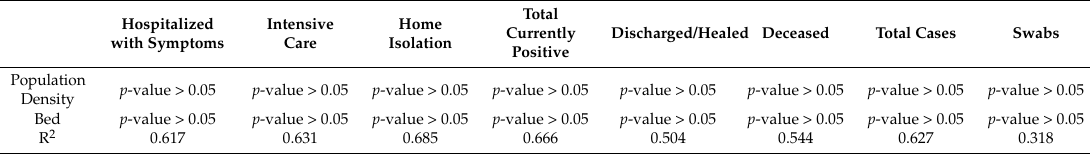
Table 3. p -values associated with the Population Density and Intensive Care Beds and the Multiple R-squared.